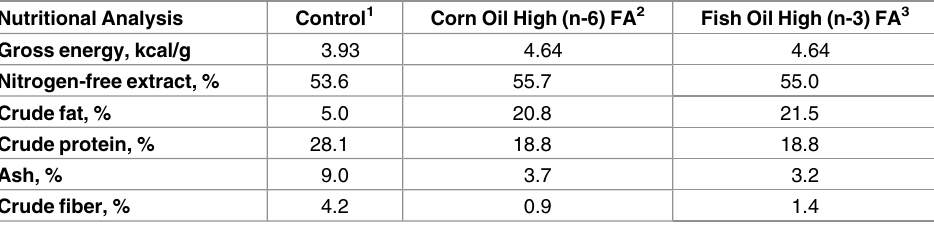
1 Food ingredients included dehulled soybean meal, wheat middlings, flaked corn, ground corn, fish meal, cane molasses, ground wheat, dried whey, soybean oil, brewers dried yeast, and vitamins and minerals. Minerals included 1.36% calcium as dicalcium phosphate and calcium carbonate, 1.01% phosphorus, 0.29% sodium as iodized salt, 0.49% chlorine, 1.04% potassium as chromium potassium sulfate, 0.28% magnesium as magnesium oxide, 352.14 mg/kg iron as ferrous sulfate, 105.39 mg/kg manganese as manganous oxide, 82.87 mg/kg zinc as zinc oxide, 24.42 mg/kg copper as copper sulfate, 2.46 mg/kg iodine as calcium iodate, 0.71 mg/kg cobalt as cobalt carbonate, and 0.33 mg/kg selenium. Vitamins included 12.90 IU/g vitamin A as vitamin A acetate, 2.40 IU/g vitamin D 3 , 90.18 IU/kg vitamin E, 2.53 mg/g choline as choline chloride, 63.42 mg/kg niacin, 21.03 mg/kg pantothenicacid as calcium pantothenate, 12.95 mg/kg vitamin B 6 as pyridoxine hydrochloride, 7.85 mg/kg vitamin B 2 , 27.95 mg/kg vitamin B 1 as thiamine mononitrate, 4.11 mg/kg vitamin K 3 as menadionesodium bisulfate complex, 2.72 mg/kg folic acid, 0.39 mg/ kg biotin, and 51.20 mcg/kg vitamin B 12 . 2 Food ingredients (by weight) included 35.58% sucrose, 20.00% casein purified high nitrogen, 20.00% corn oil, 15.00% corn starch, 5.00% alphacel, non-nutritive bulk, 4.00% mineral mix, 0.30% dl-methionine, and 0.12% dl- α -tocopherol powder (250 IU/g). The mineral mix contained (g/kg mineral mix): 500 g calcium phosphate dibasic, 220 g potassium citrate monohydrate, 74 g sodium chloride, 52 g potassium sulfate, 24